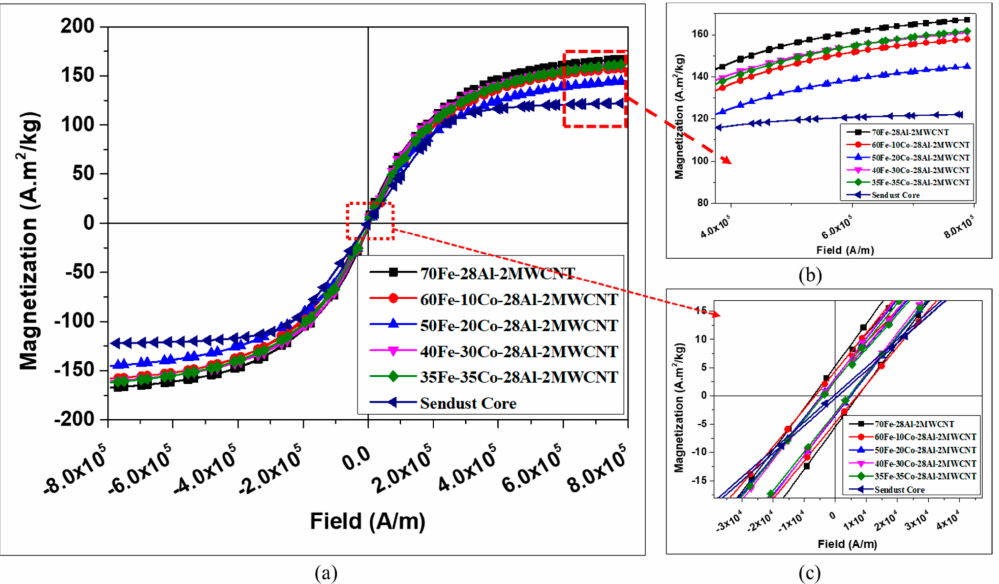
Figure 10. Comparison of hysteresis loops of the Fe-Al-MWCNT and Fe-Co-Al-MWCNT composites: ( a ) Full loops; ( b ) and ( c ) magnification of selected